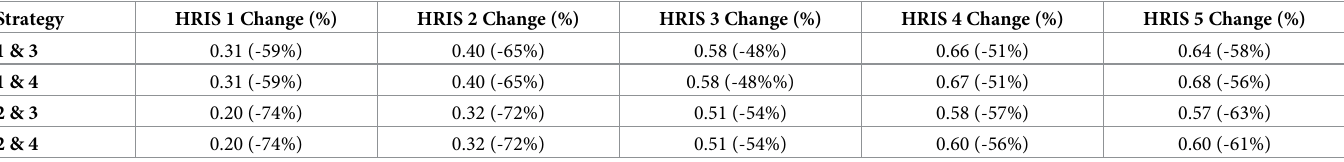
Table 18. Effect of combination of strategies on headway regularity